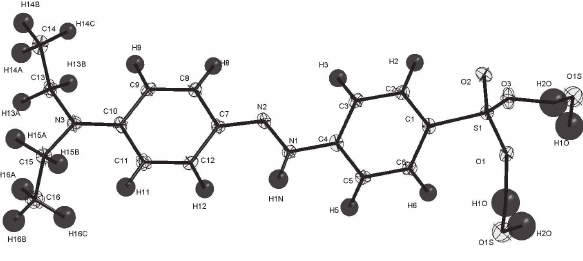
Table 1: Data collection and handling.